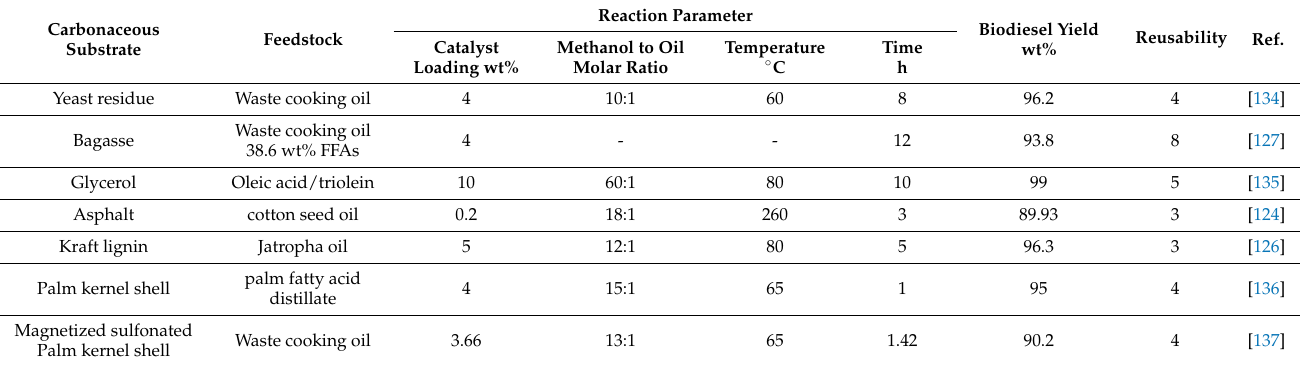
Table 6. Carbon-based solid acid catalysts for biodiesel